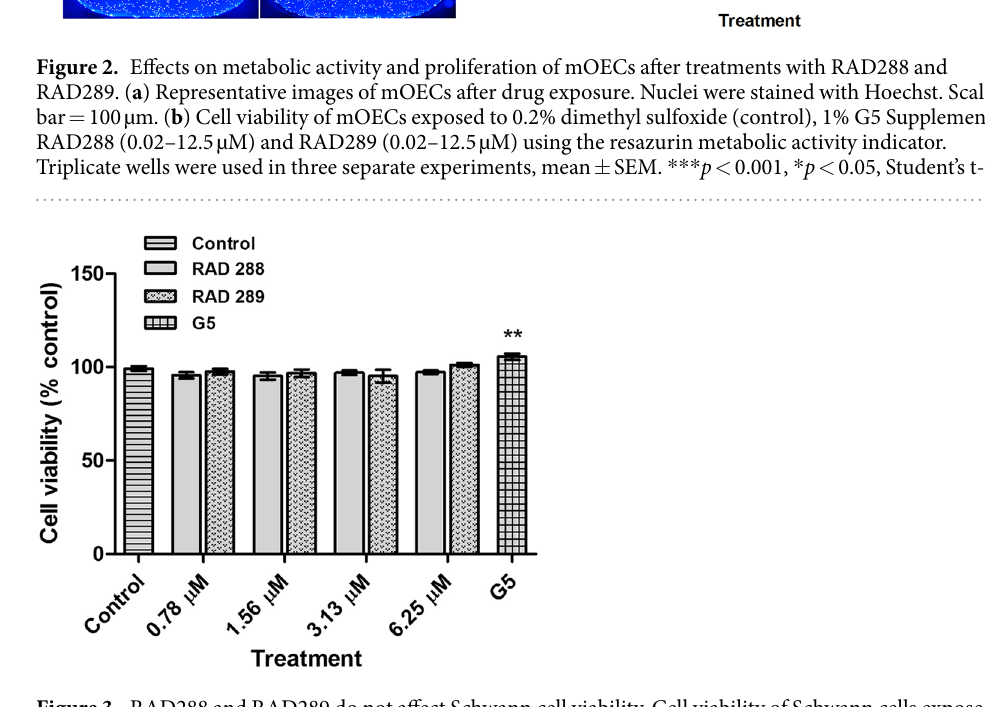
Figure 3. RAD288 and RAD289 do not affect Schwann cell viability. Cell viability of Schwann cells exposed to 0.2% dimethyl sulfoxide (control), 1% G5 supplement, RAD288 (0.78–6.25 µ M) and RAD289 (0.78–6.25 µ M) using the resazurin metabolic activity indicator. Triplicate wells were used in three separate experiments, mean ± SEM, ** p < 0.01, Student’s